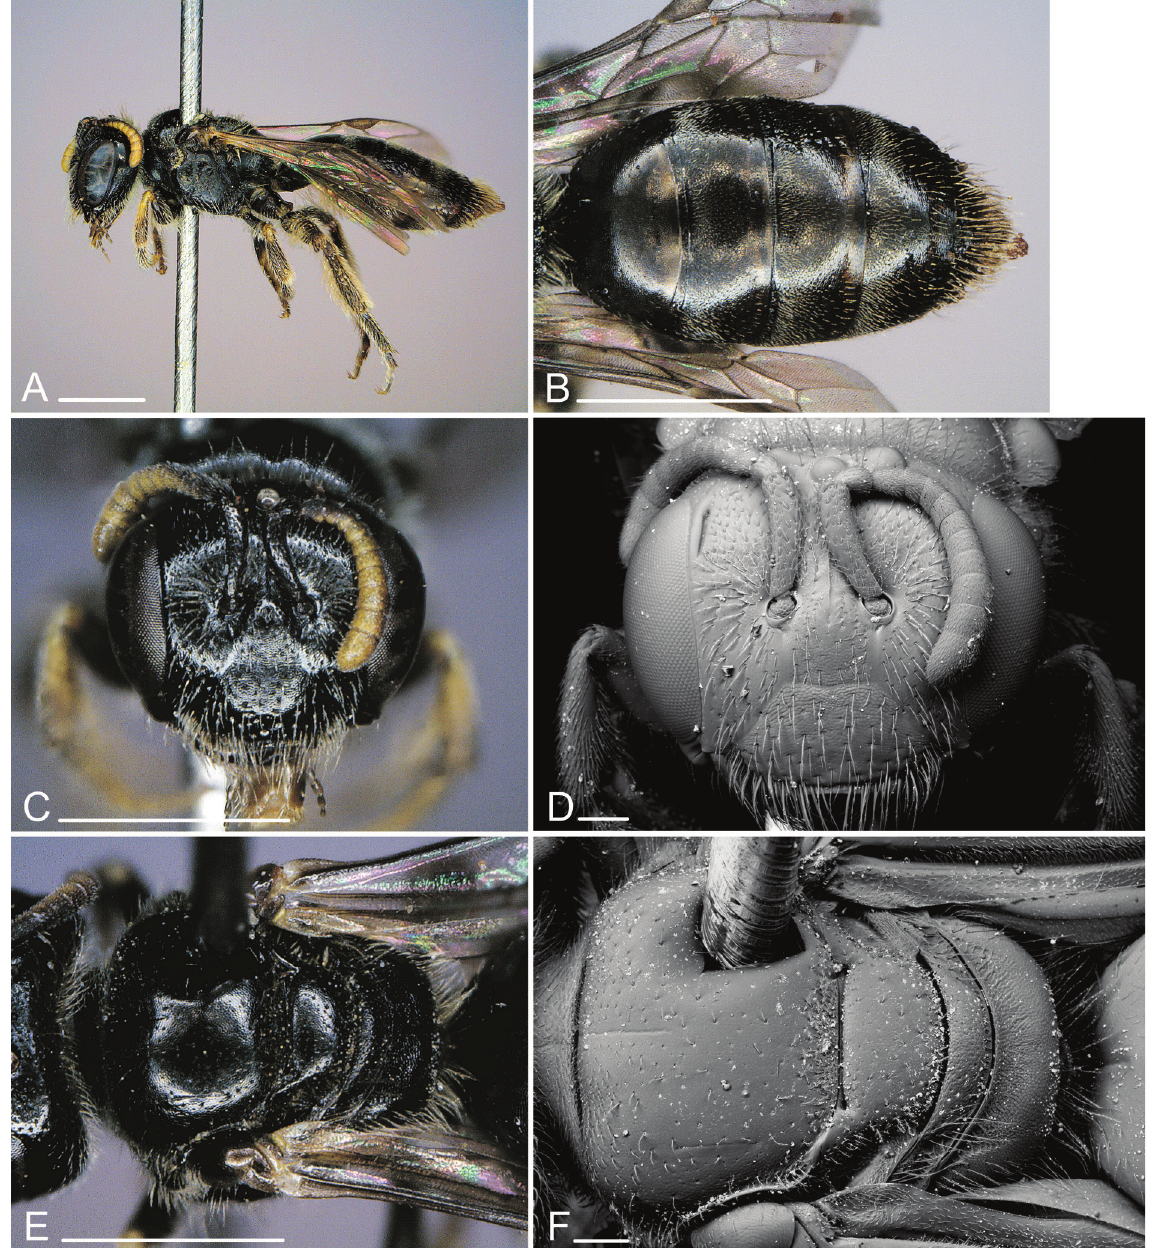
Fig. 8. Scrapter gessorum sp. nov., ♀. A . Lateral view. B . Metasoma (dorsal view). C . Head. D . Head (SEM). E . Thorax (dorsal view). F . Thorax (dorsal view, SEM). Scale bars: photos: 1 mm, SEM: